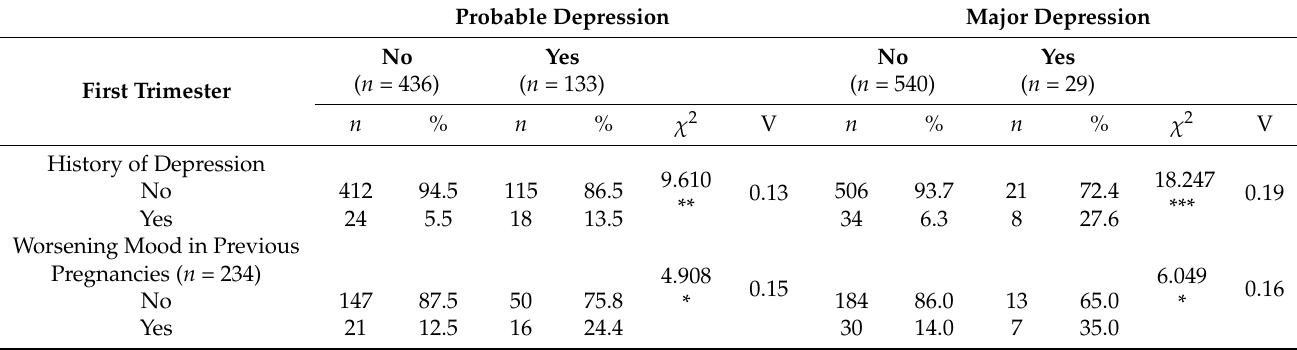
Table 3. Characteristics of women with probable depression and major depression regarding psychological variables. Probable Depression Major